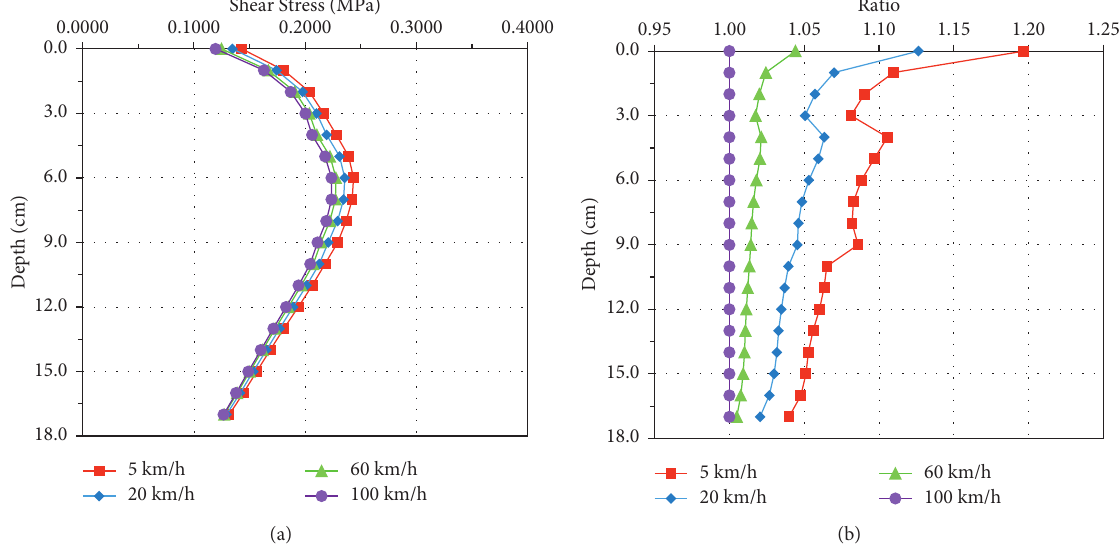
Figure 12: Distribution of shear stress along with the depth under the different truck speed: (a) normal value and (b) standardized value.